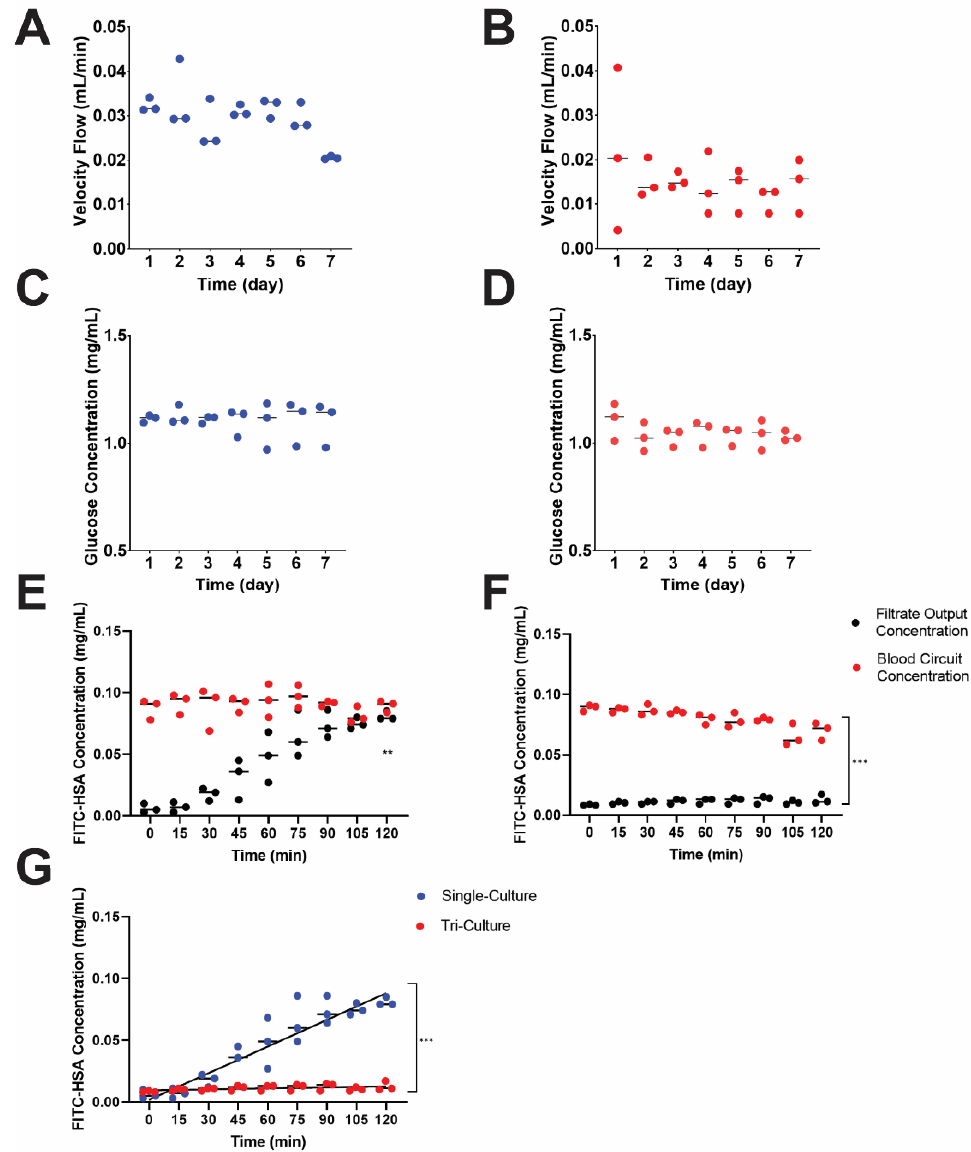
Figure 5. Functional comparison of glomerular and proximal convoluted tubule (PCT) MPS in single- and tri-culture conditions ( n = 3 microsphyiological system [MPS] devices/condition). ( A , C , E ) represent single-culture experimental tests with no glomerular cells, and ( B , D , F ) depict a tri-culture MPS with a glomerulus housing unit. ( A ) Filtrate output formation in single culture. ( B ) Filtrate output formation in tri-culture. ( C ) Glucose secretion in single culture. ( D ) Glucose secretion in tri-culture. ( E ) Protein filtration of FITC-human serum albumin (HSA) in single culture. (** Comparison of individual datapoints within filtrate output, p < 0.01, non-parametric one-way ANOVA.) ( F ) Protein filtration of FITC-HSA in tri-culture. (*** Comparison of individual datapoints within blood circuit and filtrate output, p < 0.001, non-parametric one-way ANOVA and Mann–Whitney test.) ( G ) HSA concentration of filtrate output in single and tri-culture. (*** Comparison of HSA output rates in filtrate between single and tri-cultures, p < 0.001, linear regression, R single2 = 0.86, R tri2 = 0.20. y tri = 7.2 × 10 − 4 t + 1.7 × 10 − 3 and y single = 2.6 × 10 − 5 t + 9.5 × 10 − 3 ).